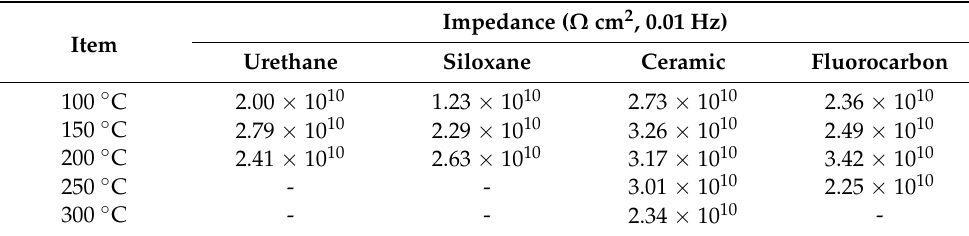
Table 9. Electrochemical Impedance Spectroscopy (EIS) according to heating temperature.